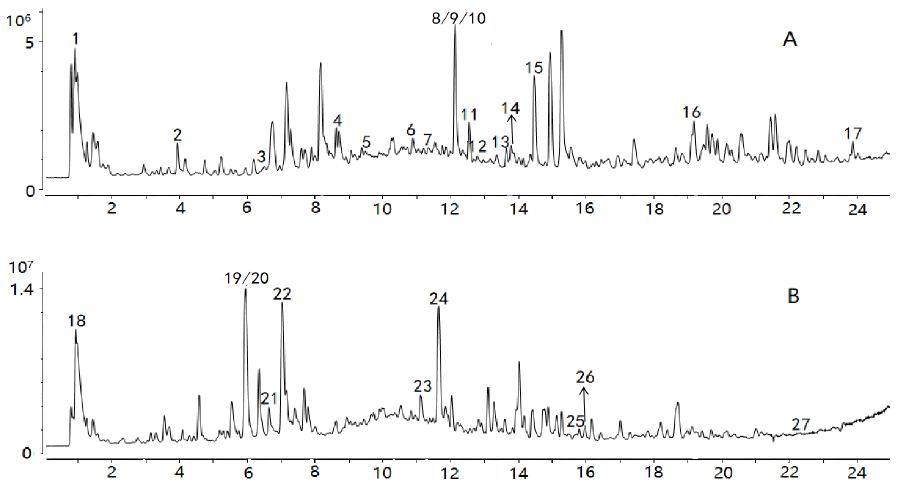
Figure 3. TIC of the sample in positive ( A ) and negative ions ( B ).